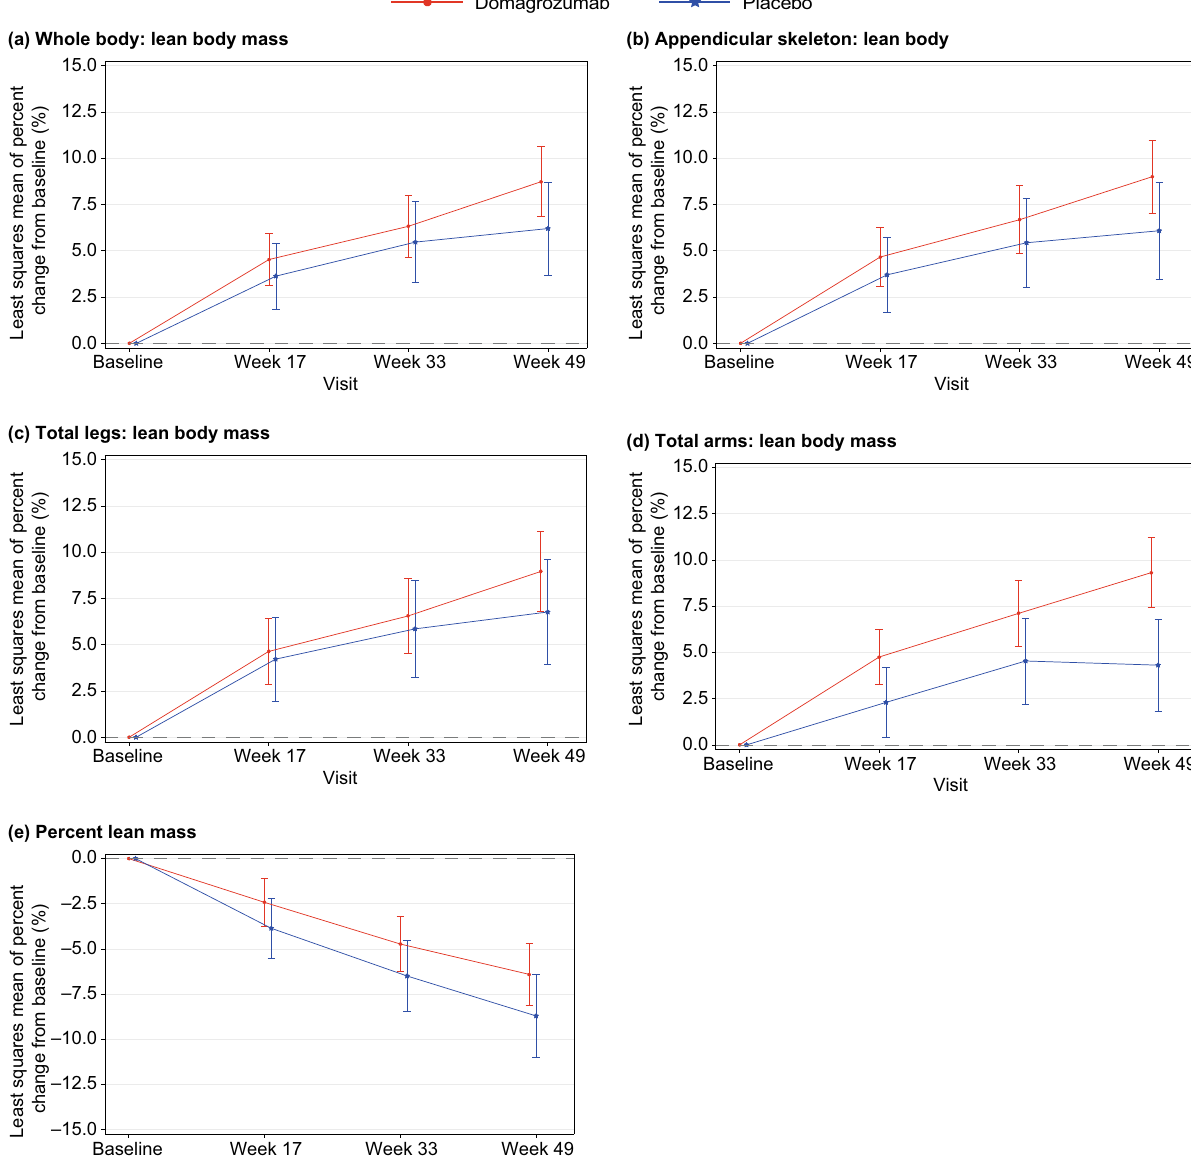
Figure 2. Change from baseline in DXA lean body mass. Least-squares mean change from baseline in lean body mass at Weeks 17, 33 and 49 for ( a ) whole body, ( b ) appendicular skeleton, ( c ) total legs and ( d ) total arms; ( e ) shows percent lean mass. DXA, Dual-energy X-ray